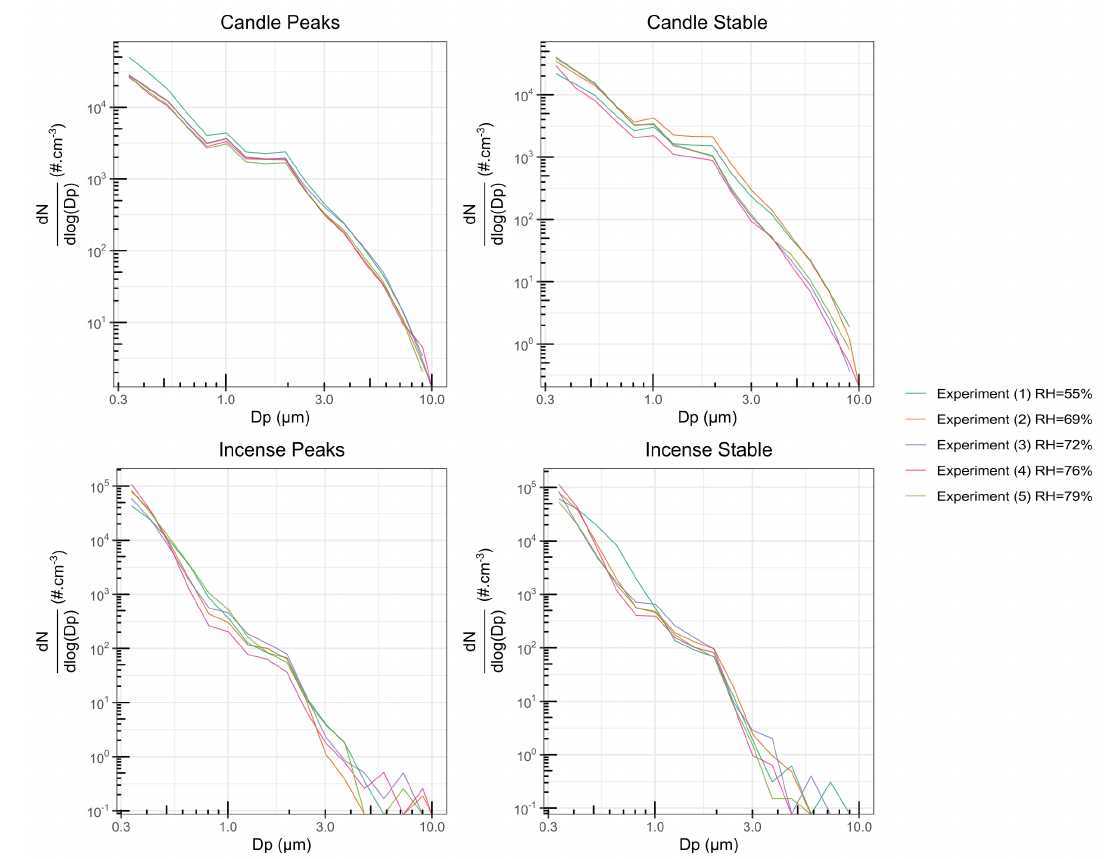
Figure A1. Size distribution measured by the OPS during the different experiments for peaks and stable concentrations of incense and candle smoke. The axis are in a logarithmic scale. N is the number of particles in #1/cm 3 , D p is the mean diameter of the